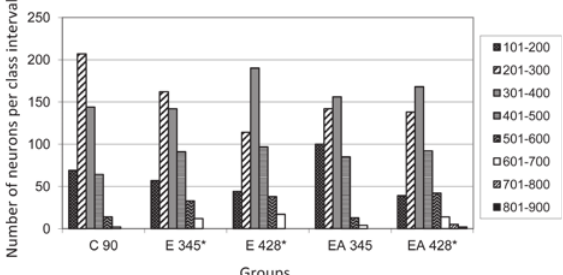
Fig. 3 - Distribution of myosin-V immunoreactive myenteric neurons by cellular profile area, at 100 μm 2 class intervals in the duodenum of rats at different ages: C90 days, E 345days, E428 days, and supplemented with AA: EA 345 and EA 428 days. Asterisks indicate groups that showed a significant increase in the soma as compared to those